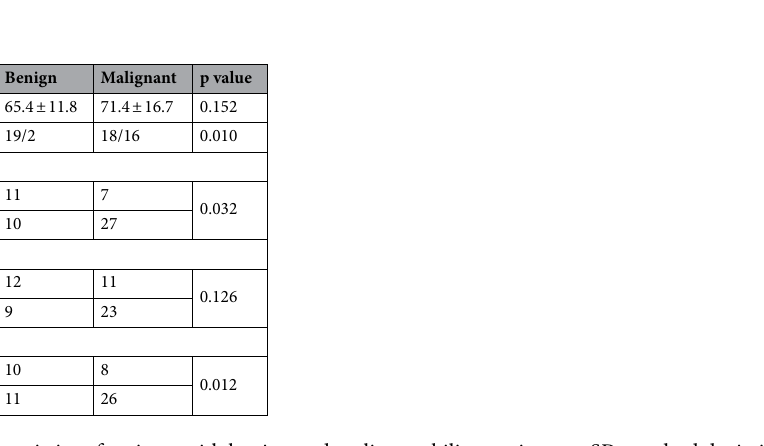
Table 2. Basic characteristics of patients with benign and malignant biliary strictures. SD standard deviation.